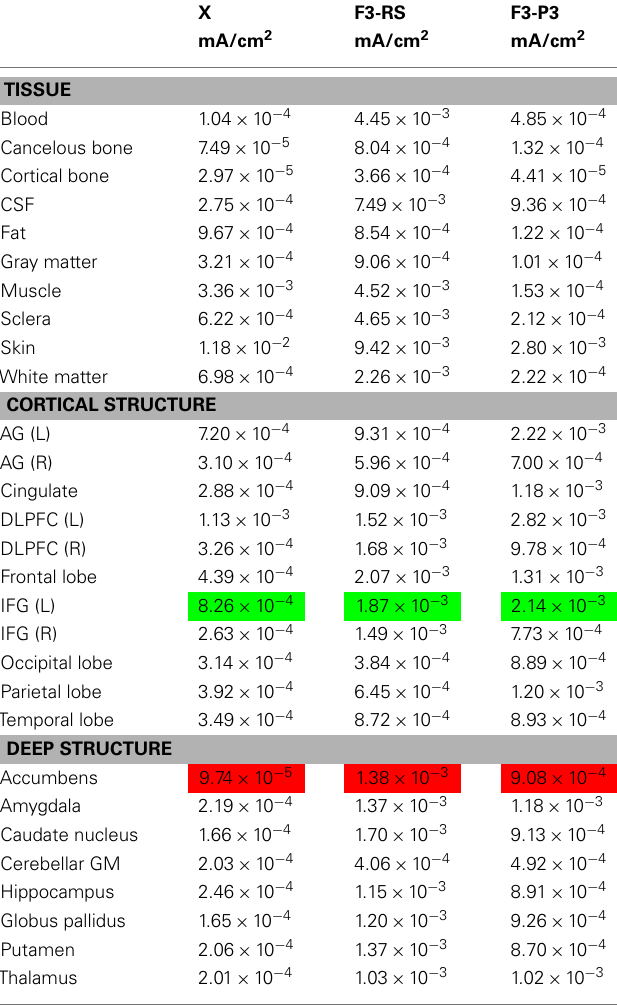
Table 2 | Median current density values found in different tissues and structures for Problem